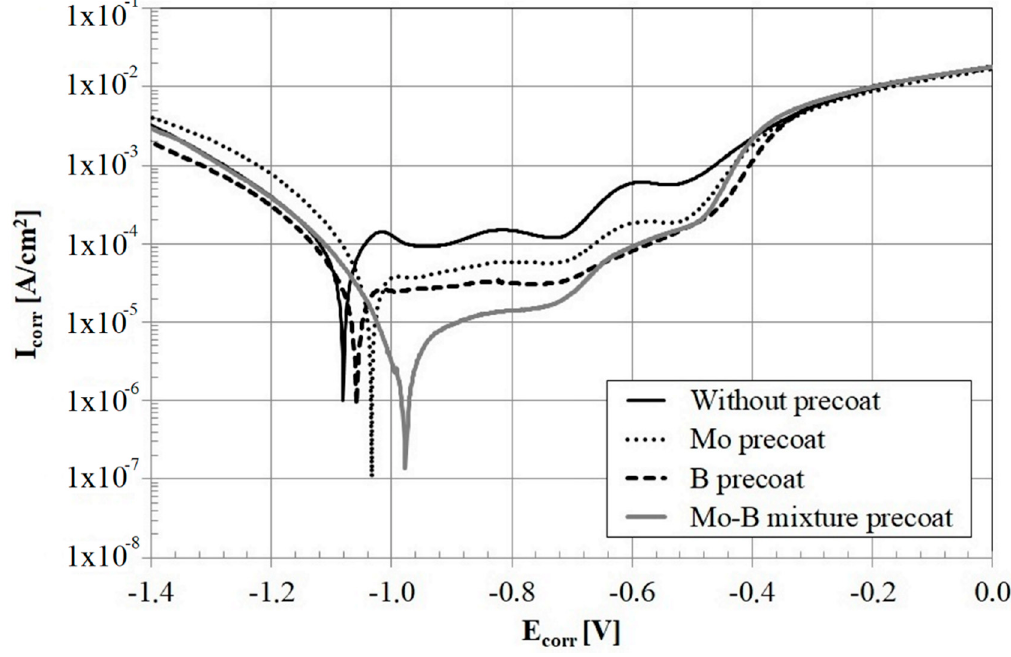
Figure 9. Corrosion resistance of the studied materials and coatings containing molybdenum, boron, and mixture of boron and molybdenum, E corr ranged from − 1.40 to 0.0 V.